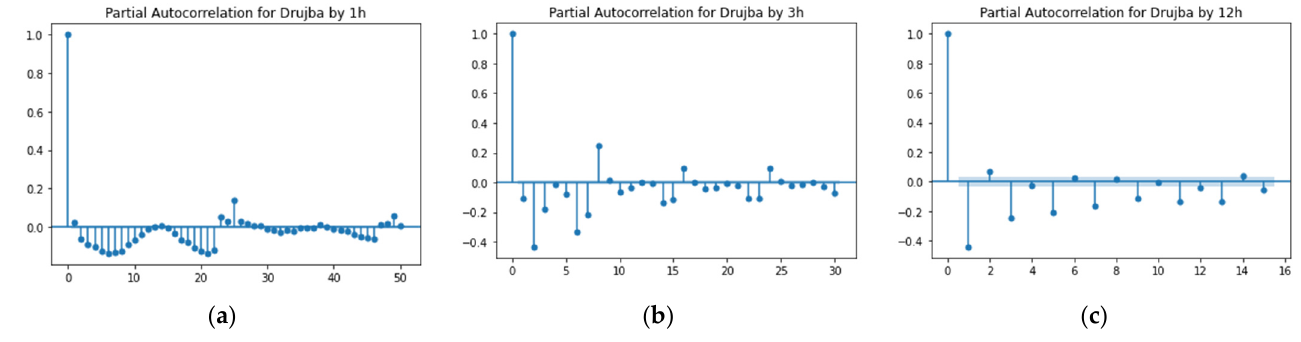
Figure 12. Partial autocorrelation of NO 2 in “Drujba” air quality station measured at 1 h granularity ( a ), 3 h granularity ( b ) and 12 h granularity ( c ) with lag difference 1. Table 9. Values of the ADF and KPSS tests applied on the NO 2 dataset for granularities: 1 h with lag difference 1, 3 h with lag difference 1 and 12 h with lag difference 1.